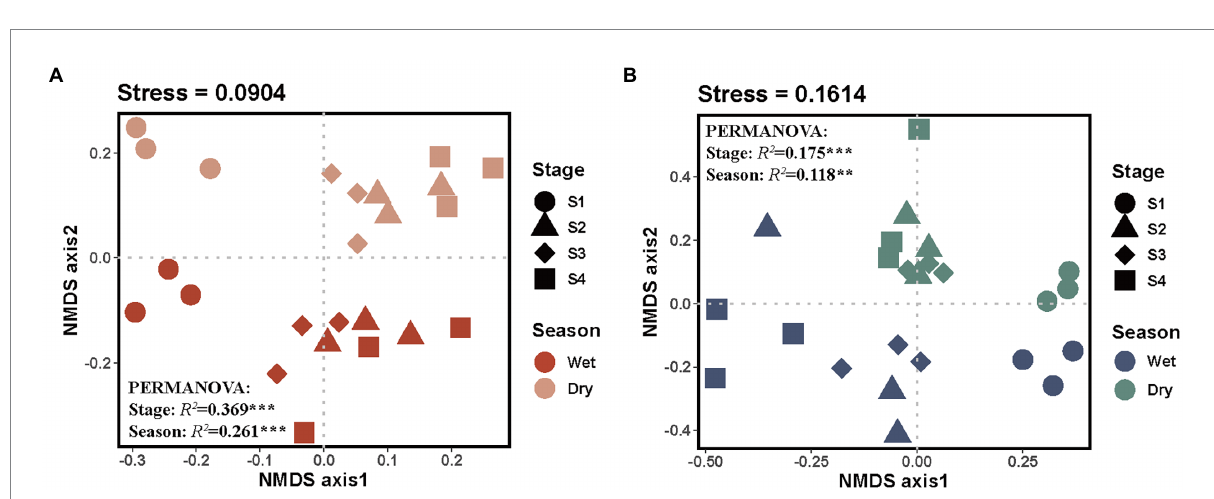
FIGURE 3 Nonmetric multidimensional scaling ordinations of the Bray–Curtis dissimilarity matrices of bacterial (A) and fungal (B) communities. S1, initial stage; S2, early stage; S3, middle stage; S4, late stage. Numbers after “Stage” and “Season” are R 2 , representing the variation in bacterial and fungal community composition that can be explained by forest succession or season, detected using PERMANOVA. ** and *** denote the significant level at p < 0.01 and p < 0.001,